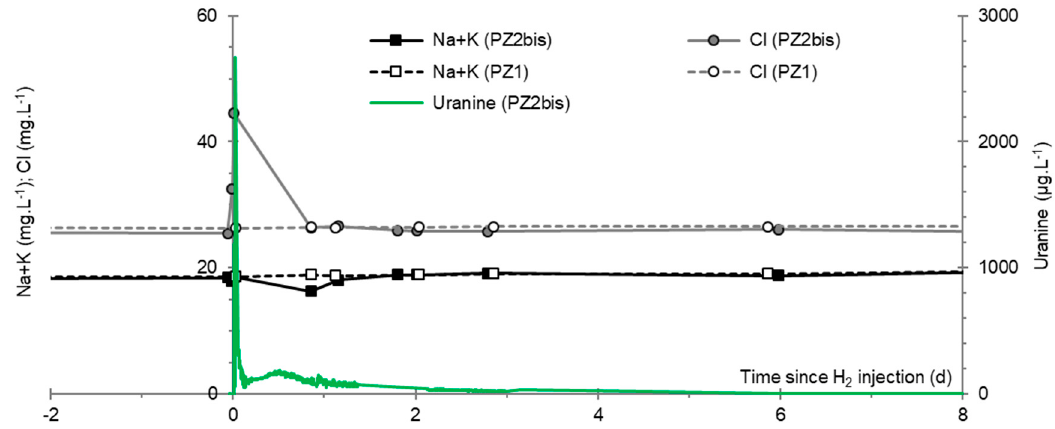
Figure 24. Comparative evolution of the concentrations of chlor-alkali ions and tracer at PZ1 (20 m upstream) and PZ2BIS (5 m downstream) during the week of experiment.